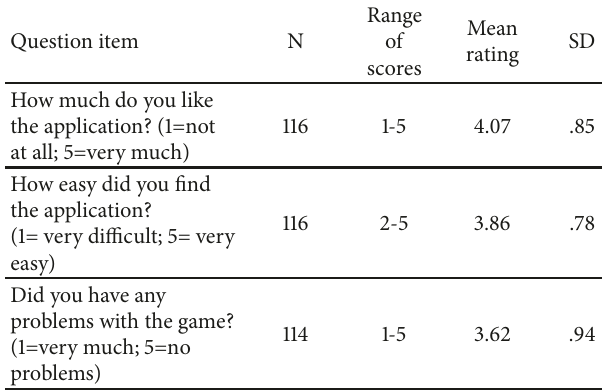
Table 1: Affective reactions from the SIAK application using the smiley-o-meter rating scale (NB: some items had lower N due to participants not filling in every